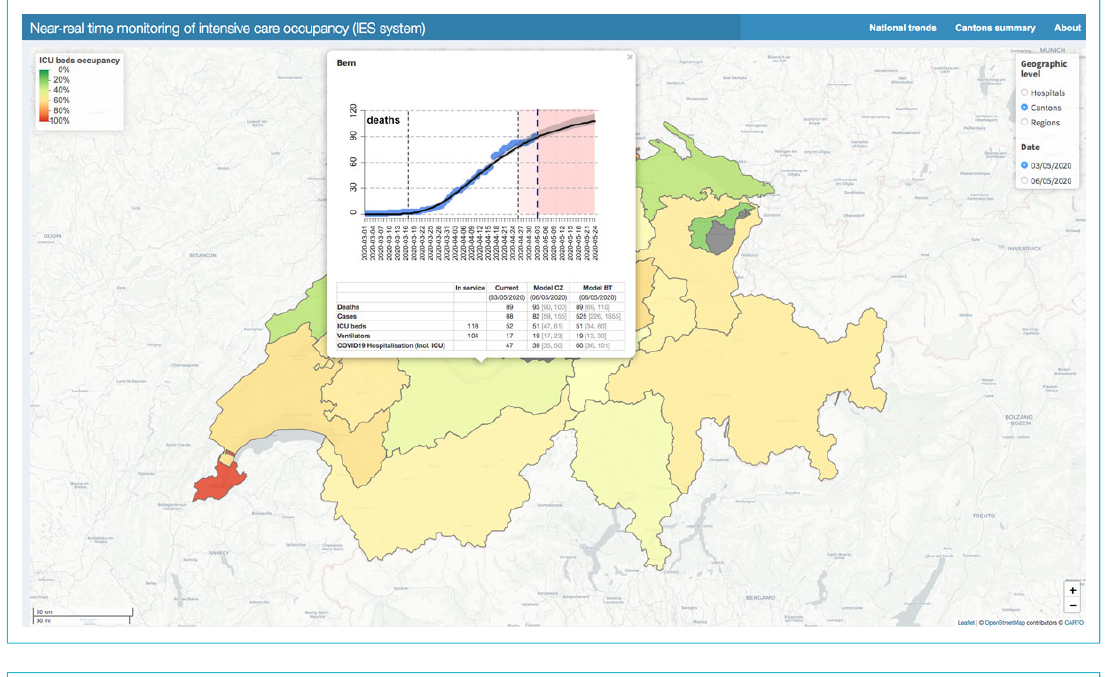
Figure 4: Canton-level ICU occupancy, colours in other Cantons indicate ICU bed occupancy compared with the number of beds in service. Pop-up windows indicate the situation in the Canton of Bern as reported in icumonitoring.ch for 03 May 2020 and projected for 06 May 2020.